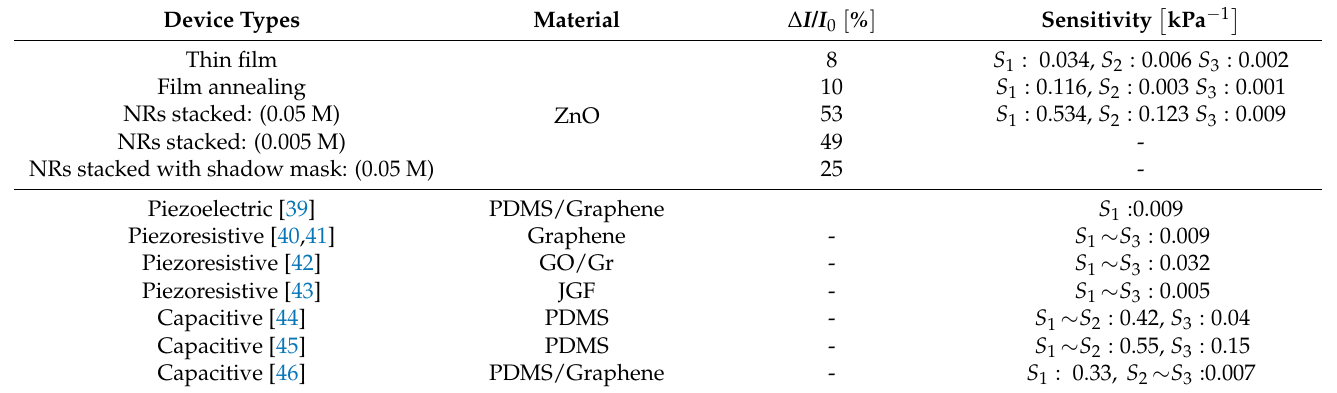
Table 3. Comparison of sensitivity and response current ratio with previous